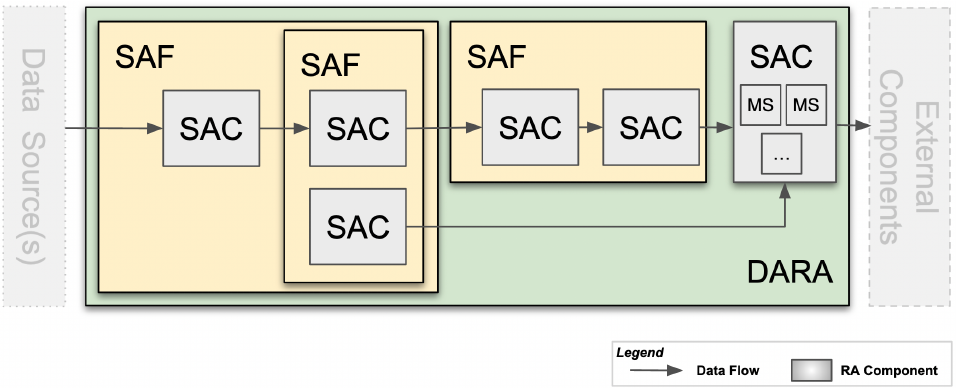
Figure 1. Relationship between Micro-Services (MS’), Software Architecture Components (SACs), Software Architecture Fragments (SAFs), and a Data Analytics Reference Architecture